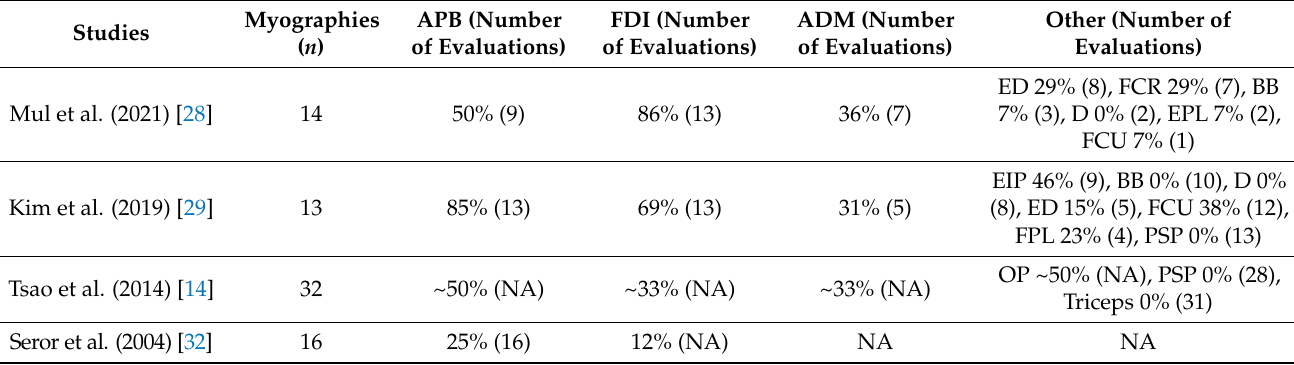
Table 4. Percentage of abnormal needle electromyographies per